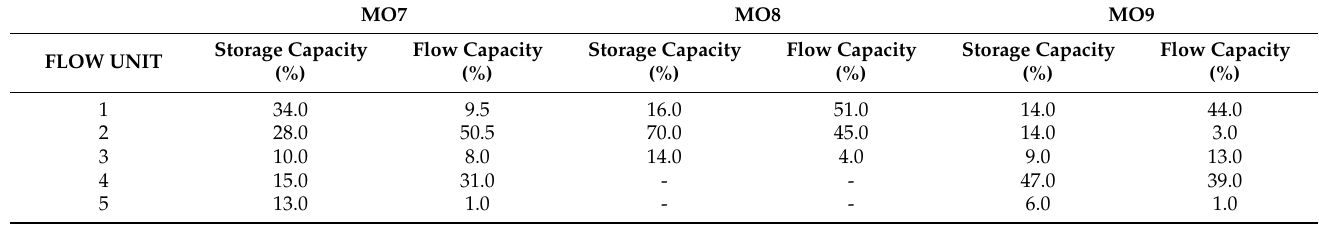
Table 2. Storage and flow capacities estimated for wells.